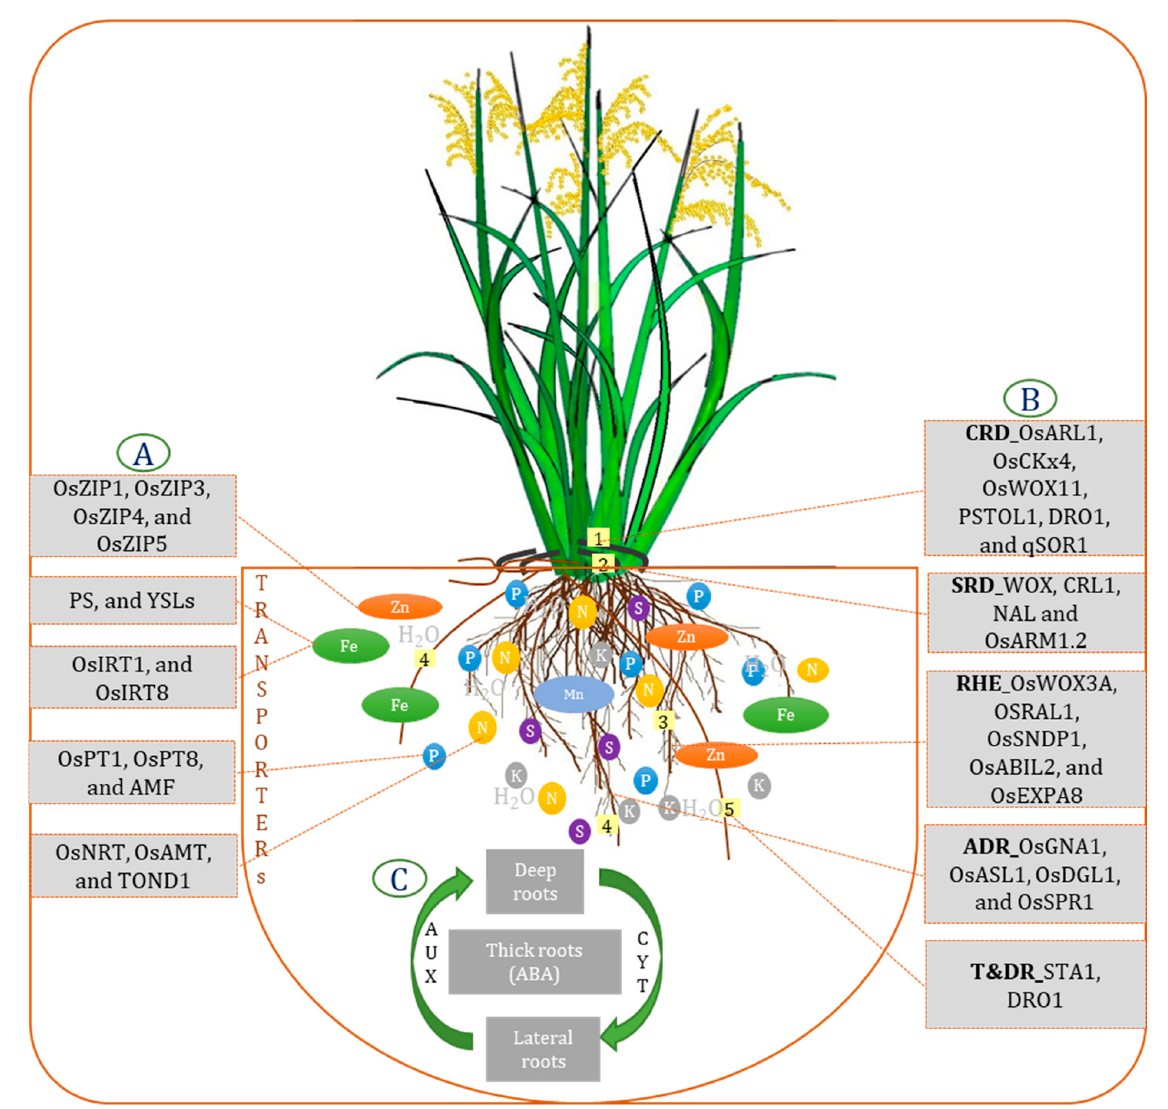
Figure 3. A schematic representation of the root growth zone and types of roots illustrated with necessary genes/QTLs for the DSR root system and their interaction with soil nutrients. The right side ( A ) indicates the essential nutrients and their transporters, and left side ( B ) indicates the specific root attributed traits along with their regulating genes/QTLs under the DSR system of rice cultivation, and the main center ( C ) indicates the hormonal regulation in development of different types of roots (CRD: Crown root development; SRD: Surface root development; RHE: Root hair elongation; ADR: Adventitious roots; and T&DR: Thick and deeper roots. Immobile nutrients (surface layer of the soil) Zn, Mn, Fe, and P are acquired by the crown roots, surface roots, and lateral roots. PSTOL1 , qSOR1 , and DRO1 help in surface root development, whereas WOX , CRL1 , and NAL genes and OsARM1,2 stimulate crown root and lateral root growth. These roots proliferate when auxin levels are low in the plant, unlike deep roots that require a higher auxin level. Thick roots are developed with the help of gene STA1 and when the abscisic acid level is high. Besides Zn and Fe transporters, phytosiderophores (root exudates) and YSLs play a role in Zn and Fe uptake. AMF colonizes in the roots, enhancing P uptake by the plant along with the respective transporters. [PS: phytosiderophores; AMF: arbuscular mycorrhizal fungi; OsPT1 and OsPT8 : phosphorus transporters; OsZIP1 , OsZIP3 , OsZIP4 , and OsZIP5 : zinc transporters; OsIRT1 and OsIRT2 : iron transporters; OsAMT : nitrogen (ammonium) transporter; OsNRT : nitrogen (nitrate) transporter; YSL: yellow stripe-like protein; TOND1: tolerance of nitrogen deficiency 1; PSTOL1 : phosphorus starvation tolerance 1; qSOR1 : soil surface rooting 1; DRO1 : deeper rooting 1; WOX : Wuschel-related homeobox gene; CRL1 : crown rootless 1; NAL: narrow-leaf; OsARM1,2 : armadillo proteins; STA1: stele transversal area 1; AUX: auxin; CTY: cytokinin; ABA: abscisic acid]. Arrows indicate the increasing/decreasing concentration of growth hormones and their involvement in root development.